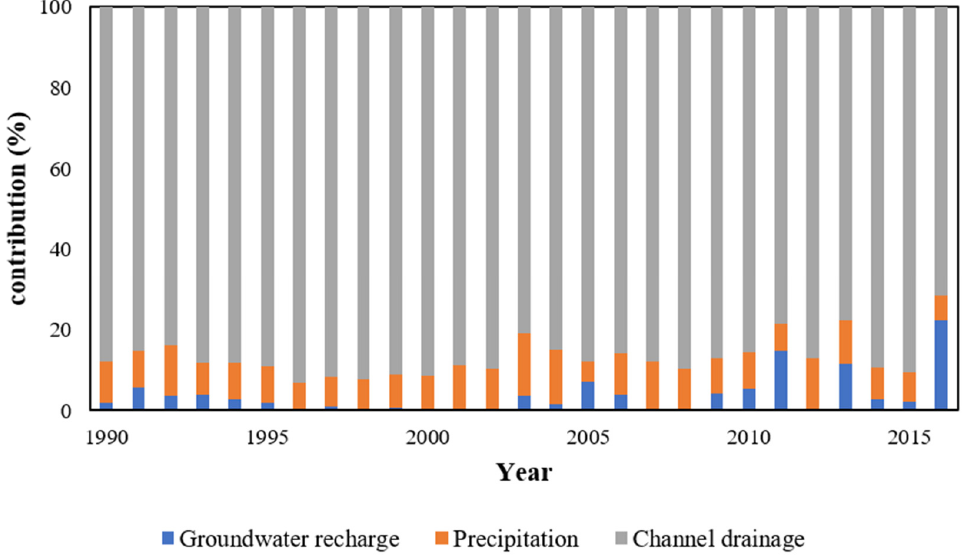
Figure 4. Changes in recharge to Wuliangsu Lake from 1990 to